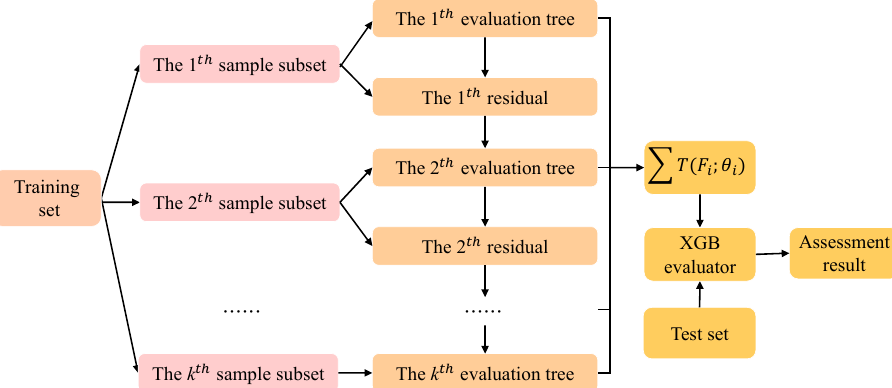
Figure 2. The work flow of the proposed extreme gradient boosting (XGB) estimator.